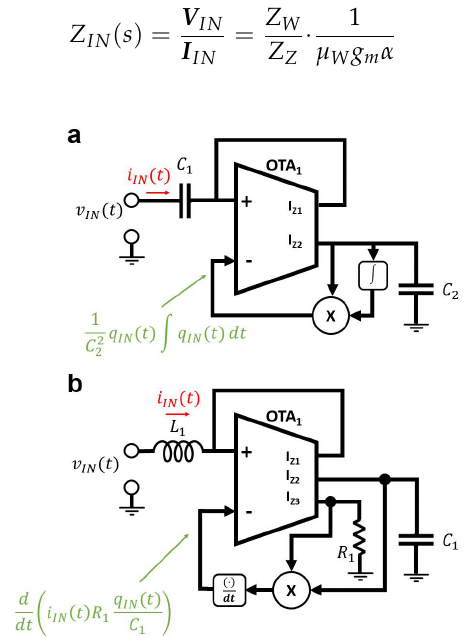
Figure 16. Memcapacitor ( a ) and meminductor emulator ( b ) circuits proposed by Babacan [59] .